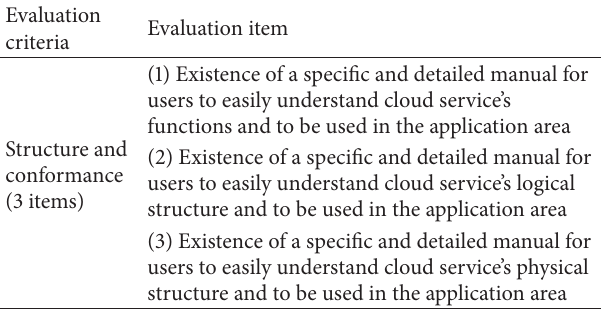
Table 2: Evaluation items of structure and conformance.